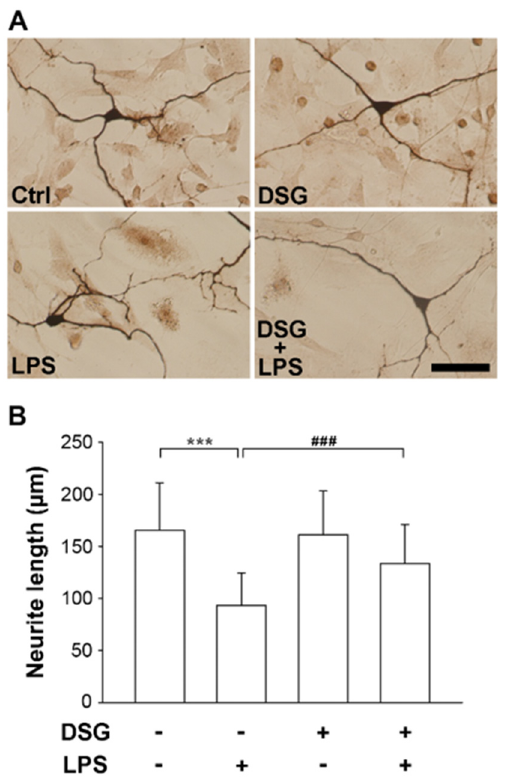
Figure 1. Effects of diosgenin on LPS-induced neurite damage in dopaminergic neurons from mesencephalic neuron-glia cultures. Rat mesencephalic neuron-glia cultures were pretreated with vehicle or diosgenin (2 µM) for 48 h and then treated with or without LPS (25 ng/mL) for 72 h. Representative images of immunostaining for tyrosine hydroxylase (TH) expression in dopaminergic neurons ( A ). Quantification of the neurite length in TH-positive dopaminergic neurons using ImageJ; as many as 50 cells were detected ( B ). The results are presented as the means ± SD. Cultured cells were analyzed in duplicate for each experiment. Three independent experiments (n = 3; duplicate cell preparations from 3 E13.5 embryos of Sprague–Dawley rats). *** p < 0.001 compared with the control; ### p < 0.001 compared with LPS-treated cultures. The scale bar equals 50 µm.